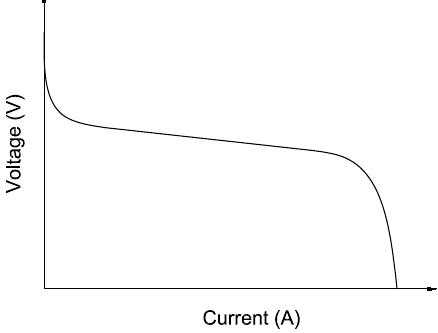
Figure 1. Characteristic polarization curve of a fuel